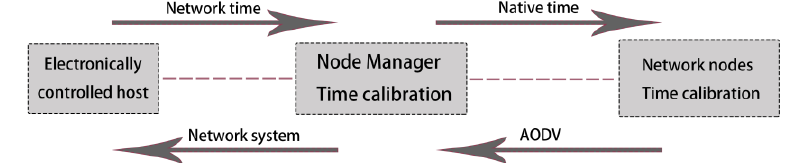
Figure 8. Time synchronization mechanism.